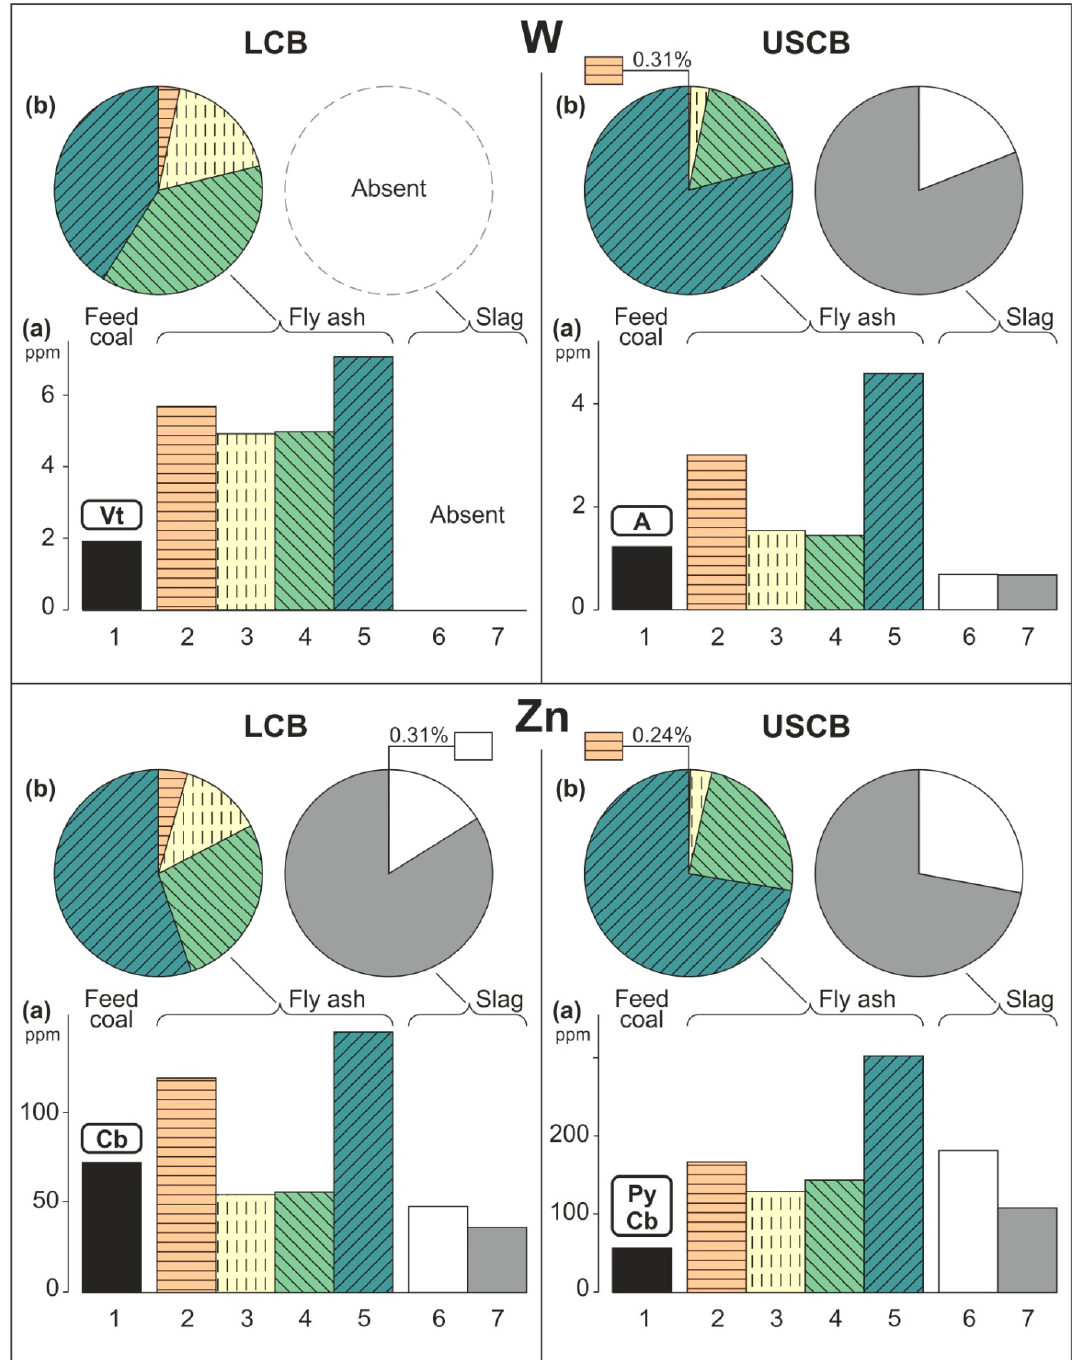
Figure 3. The distribution of EE content in the feed coal from the LCB and USCB and in the fly ash and slag ( a ), and their proportion in determining the average element concentration in fly ash and slag ( b ) (see Supplementary Materials Table S13). * Mode of occurrence of elements (Vt-vitrinite, L-liptinite, Cb-carbonate minerals, A-feed coal ash, Py-pyrite+marcasite, Sf-sulphate minerals, and QF-quartz+feldspars1), ** 1-feed coal, 2÷5 fly ash (grain with diameter: 2->0.5 mm, 3 − 0.5 ÷ 0.2 mm, 4 − 0.2